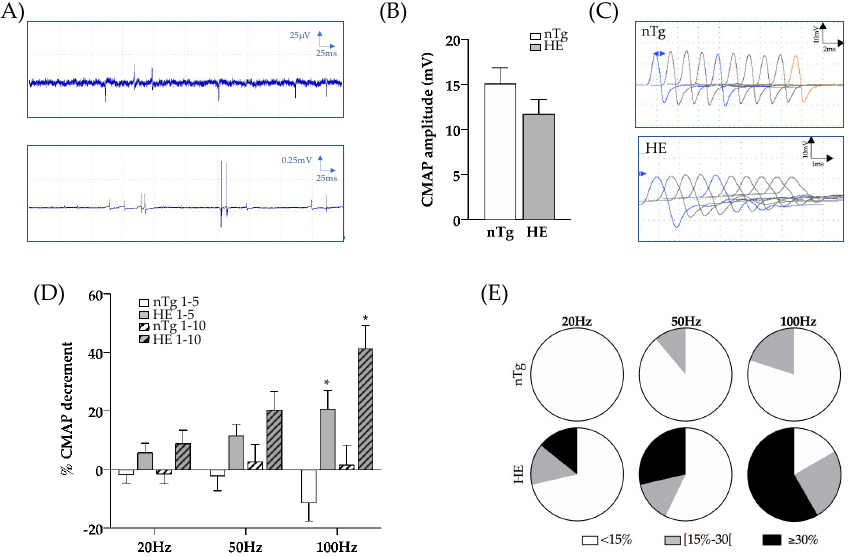
Figure 6. Electrophysiological characteristics of Gastrocnemius muscle of CHMP2B intron 5 HE mice aged 18–24 months. ( A ) Typical EMG recordings obtained in HE mice with fibrillation (top) or fasciculations (bottom). ( B ) CMAP amplitude after a single stimulation of the sciatic nerve at supramaximal intensity. ( C ) Representative CMAP response following RNS stimulation at 100 Hz. ( D ) Quantification of CMAP decrement between the first and fifth stimulations (plain histograms) or the first and the tenth stimulation (dashed histograms) after electrical stimulation of the sciatic nerve at 20, 50 and 100 Hz. ( E ) Proportion of mice with less than 15% decrement (white), between 15 and 30% decrement (grey), and more than 30% decrement (black) in the nTg and HE mice for each frequency of stimulation. Histograms represent means ± SEM; nTg n = 9 HE n = 14. Two ways ANOVA followed by Tukey’s post hoc test. * p < 0.05, genotype effect: p = 0.0008, frequency effect: p = 0.0124, and genotype x frequency effect: p = 0.0011.